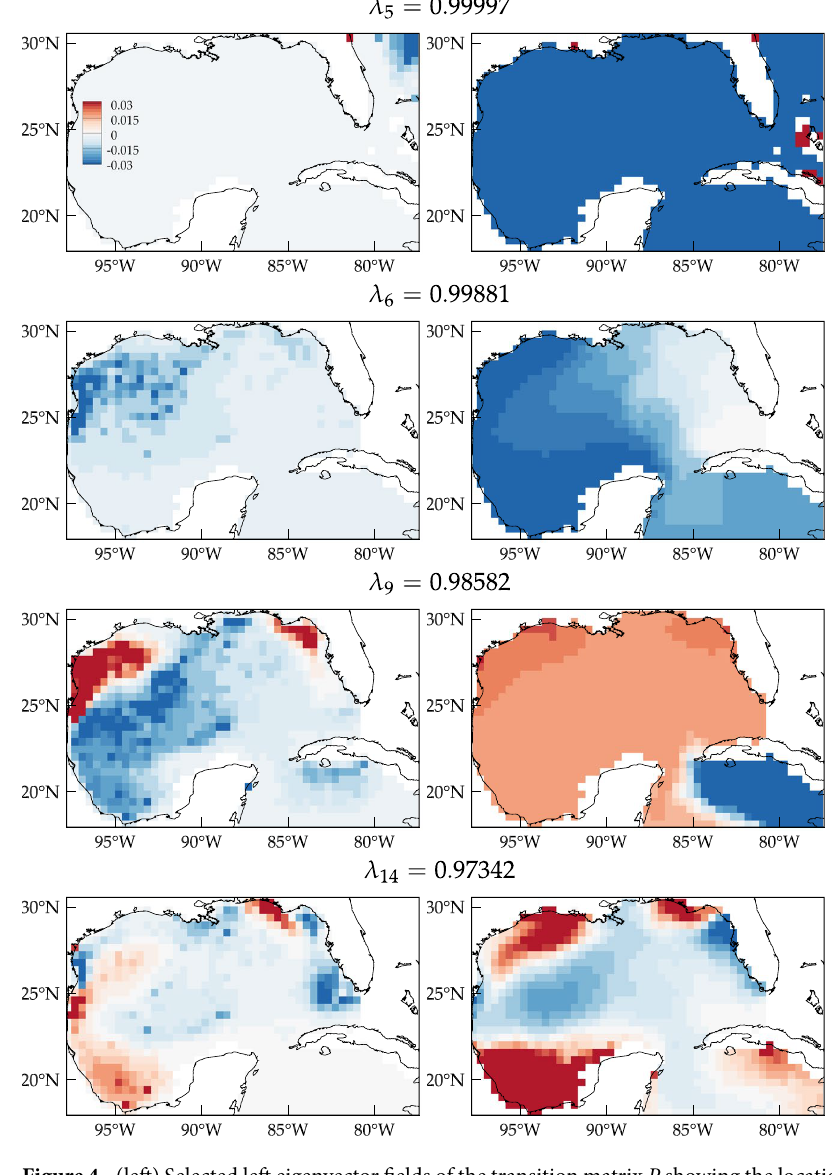
Figure 4. (left) Selected left eigenvector fields of the transition matrix P showing the locations of almost- invariant regions of forward-time attraction. (right) Corresponding right eigenvector fields showing the backward-time basins of attraction for the attractors on the left. Computations carried using Matlab R2017a (http://www.mathworks.com/) and visualization using Tecplot 360 2016 R2